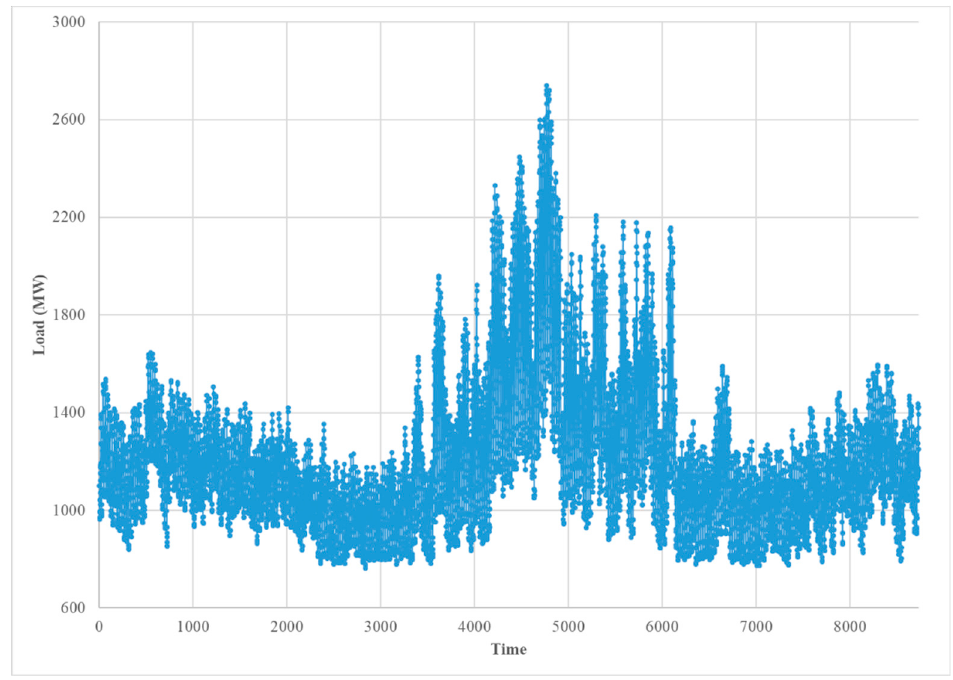
Figure 6. The hourly load of Atlantic City Electric Company (AE) in 2013.